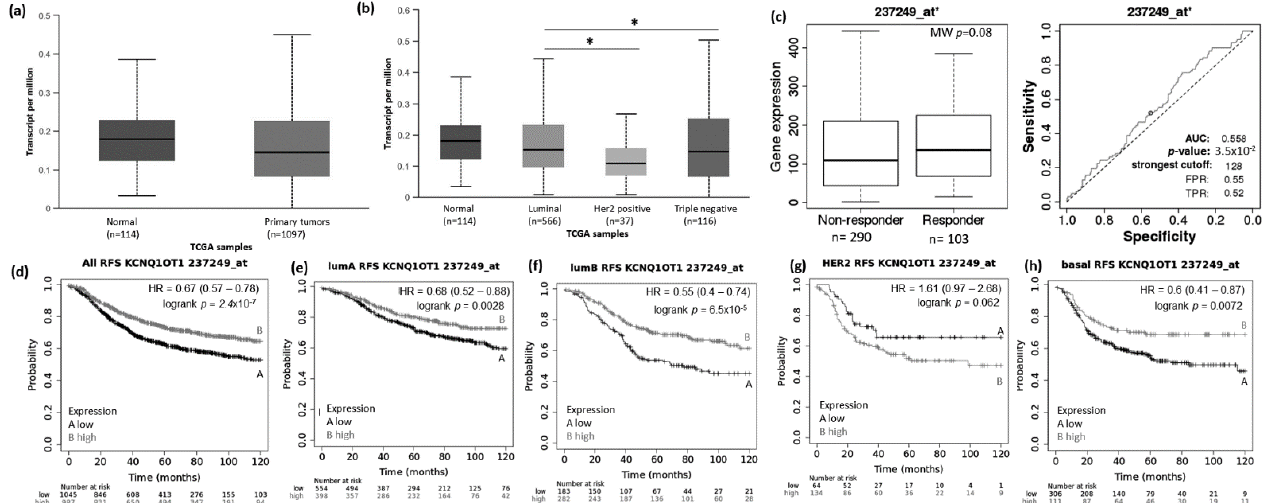
and non-responder breast cancer patients treated with taxane using the online platform ROCplot. ( d – h ) Kaplan–Meier curves for relapse-free survival of breast cancer patients for all subtypes ( d ) or for each intrinsic subtype as luminal A ( e ), luminal B ( f ), HER2 ( g ), and basal ( h ) grouped as high or low expression of MIAT according to the best cut-off value using the JetSet best probe set at the KMplotter online tool. *** p < 0.001; MW—Mann–Whitney test.